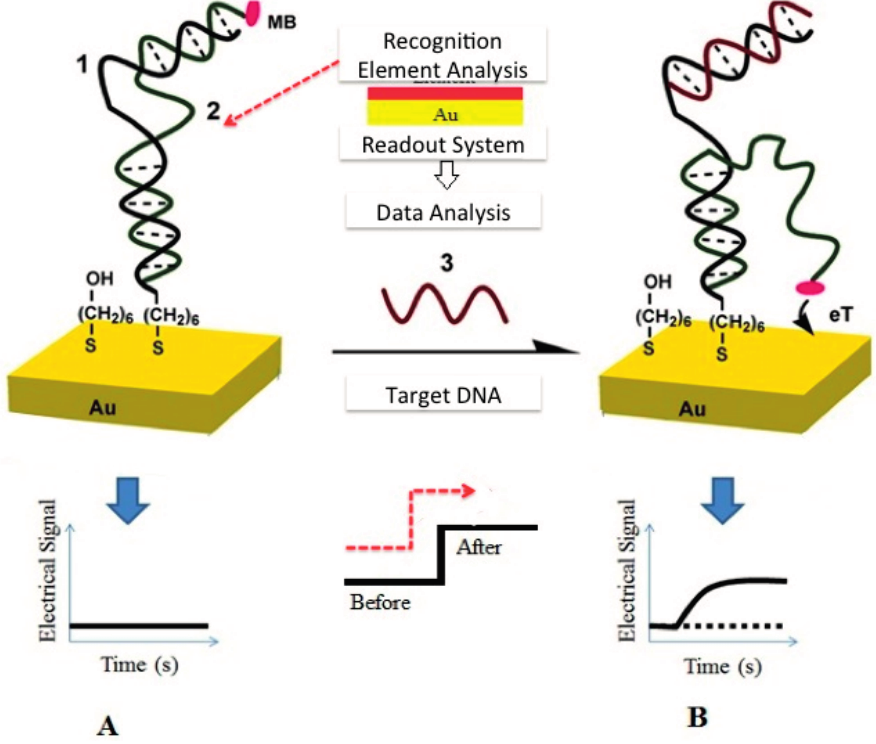
Figure 8. Electrochemical sensor: ( A – B ) schematic of an electrochemical E-DNA sensor consisting of recognition element, sensing electrode and interface circuit ( A ) prior and ( B ) after detection of target sample (Reproduced with Copyright permission from (2006) National Academy of Sciences, USA